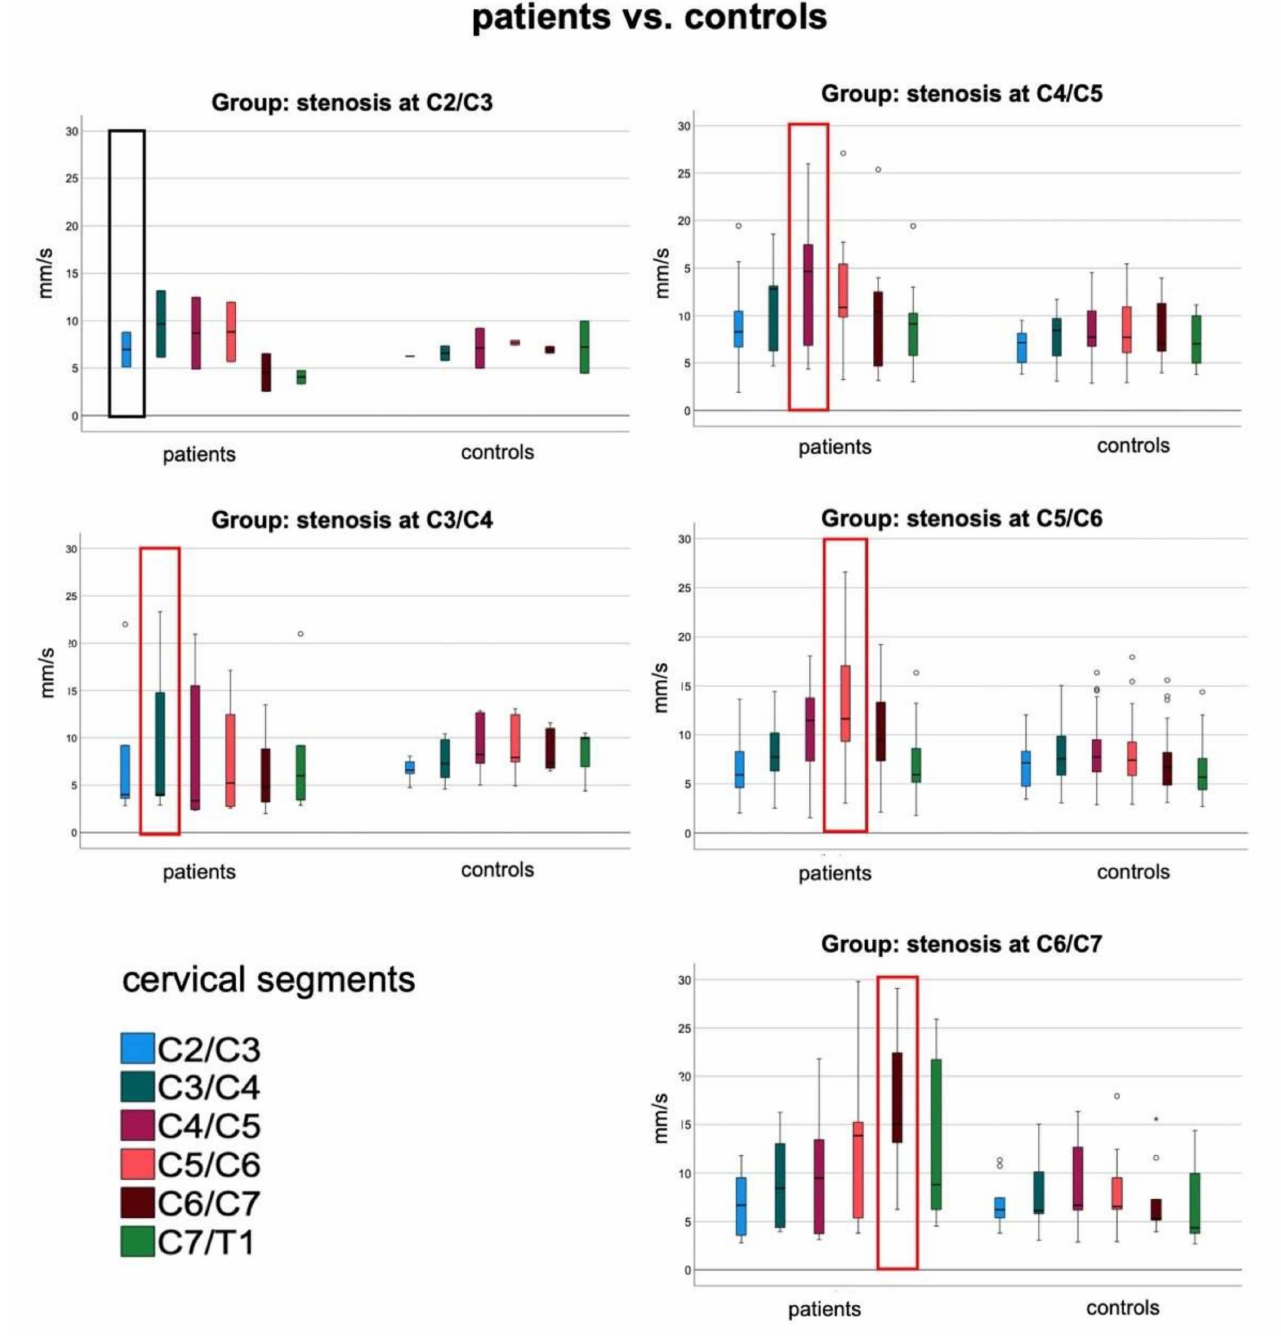
Figure 3. Boxplots per group of patients with level of stenosis at C2/C3, C3/C4, C4/C5, C5/C6, and C6/C7 compared to matched controls; the peak-to-peak amplitude of spinal cord motion is given in mm/s per cervical segment C2/C3 to C7/T1. Increase of spinal cord motion toward each level of stenosis (red rectangle) can be observed. Mild outliers are indicated by ◦ (1.5 to 3.0 × interquartile range), extreme outliers by * (>3.0 × interquartile